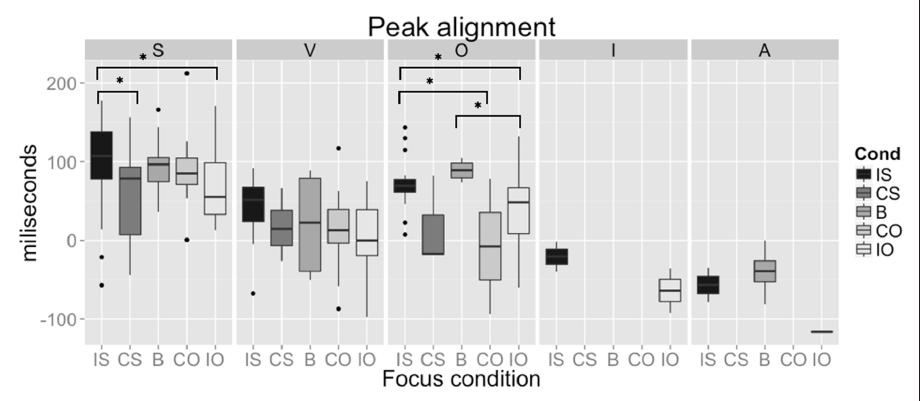
Figure 11: Peak alignment on each content word (subjects, verbs, objects, indirect objects and adjuncts) in the following focus conditions: informational focus (IS), contrastive focus (CS), broad focus (B) or non-focused in contexts of contrastive object focus (CO) and informational object focus